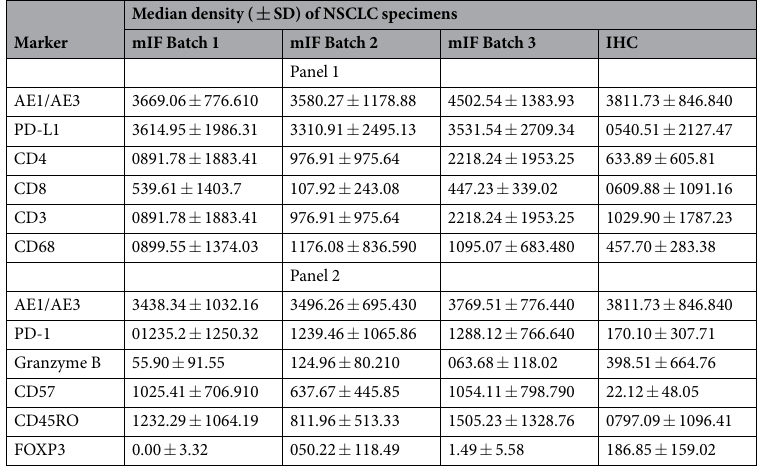
Table 1. Densities of immune markers (in mm 2 ) in the various staining batches. Note: mIF = multiplex immunofluorescence, IHC =